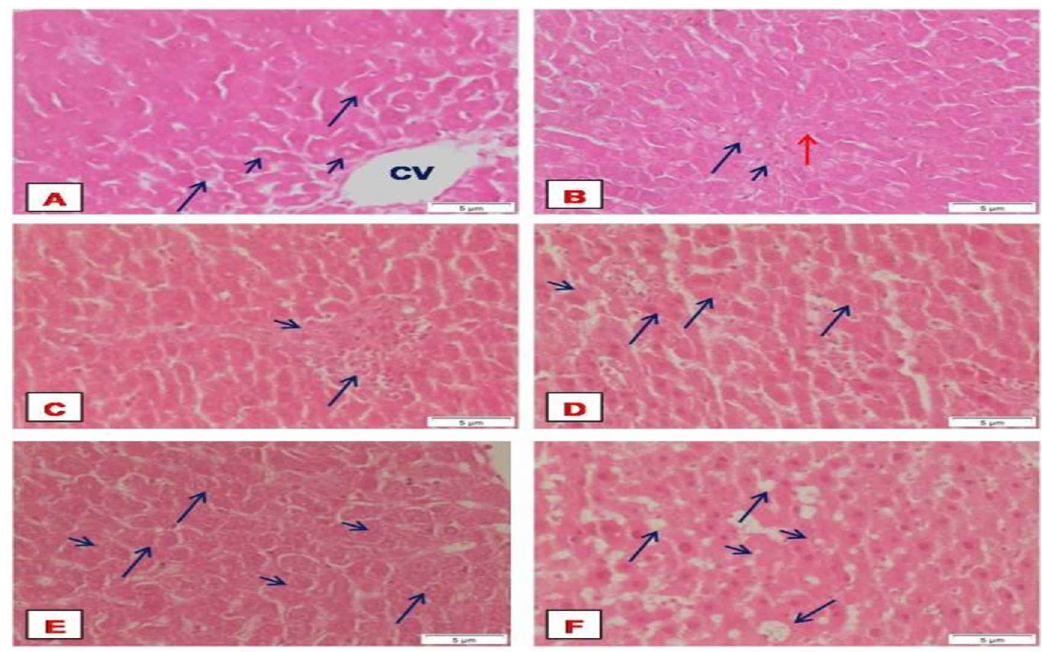
Fig 4. Photographs of liver sections stained with H & E. Normal rats showing (A) normal architecture with the central vein, normal hepatocytes (arrows) with normal nuclear size (arrowheads); (B) normal portal tract that includes portal artery (arrow), portal vein (arrowhead) and bile duct (red arrow). DEN/2-AAF induced rats showing (C) congestion of portal area (arrowhead) with an aggregation of inflammatory cells (arrow), (D) multinucleated hepatocytes (arrows), loss of radiating hepatocytes (arrowhead), (E) enlargement of hepatocytes (arrows), and nuclear size (arrowheads) (F) micro and macro-vesicular steatosis.